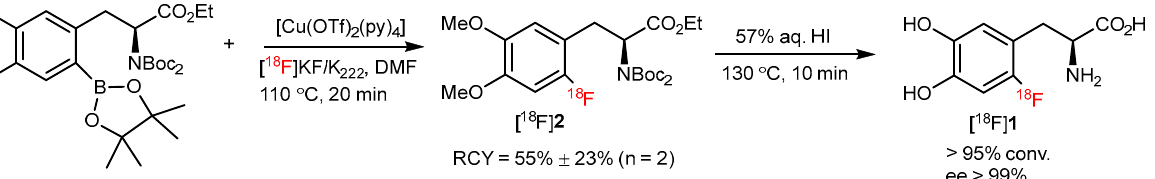
Figure 1. ( a ) Synthesis of [ 18 F] 1 through [ 18 F]F 2 . Modified from Firnau et al. [22]. ( b ) Electrophilic synthesis of [ 18 F] 1 . Modified from Diksic et al. [23]. ( c ) Synthesis of [ 18 F] 1 through an asymmetric alkylation by Shen et al. [27].